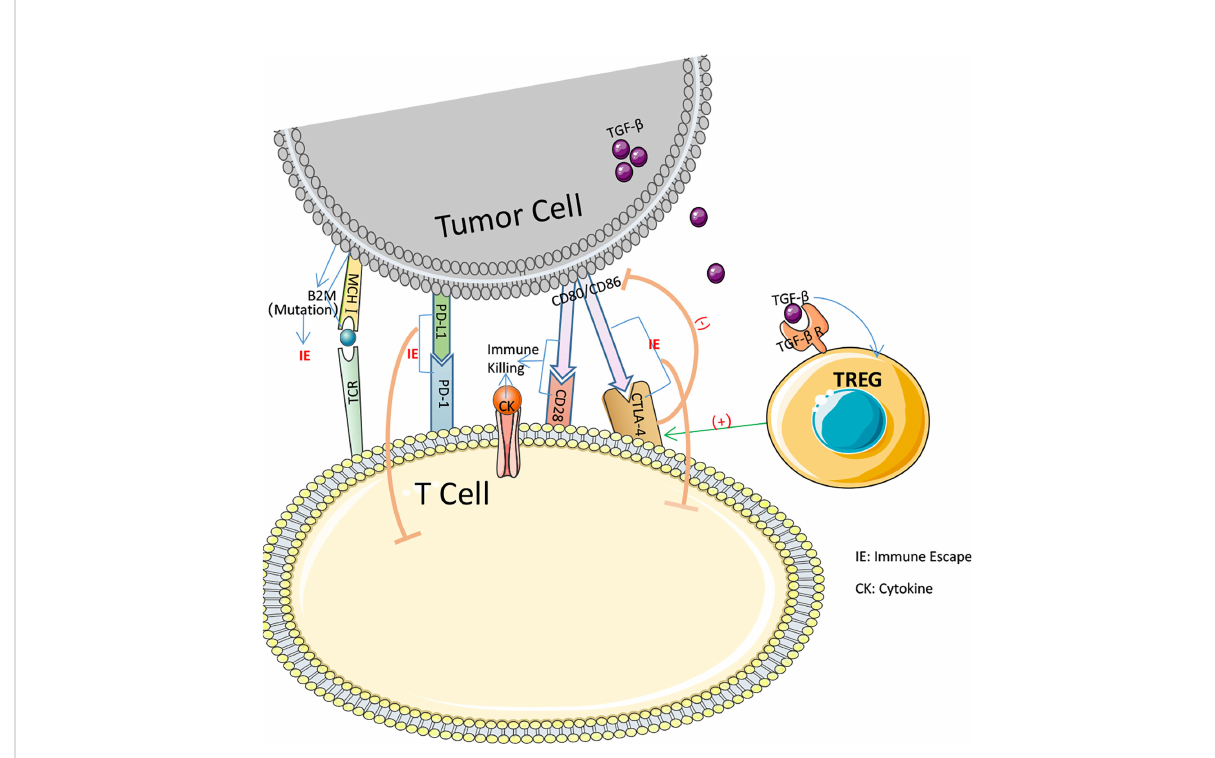
FIGURE 3 Several pathways by which immune escape occurs in colorectal